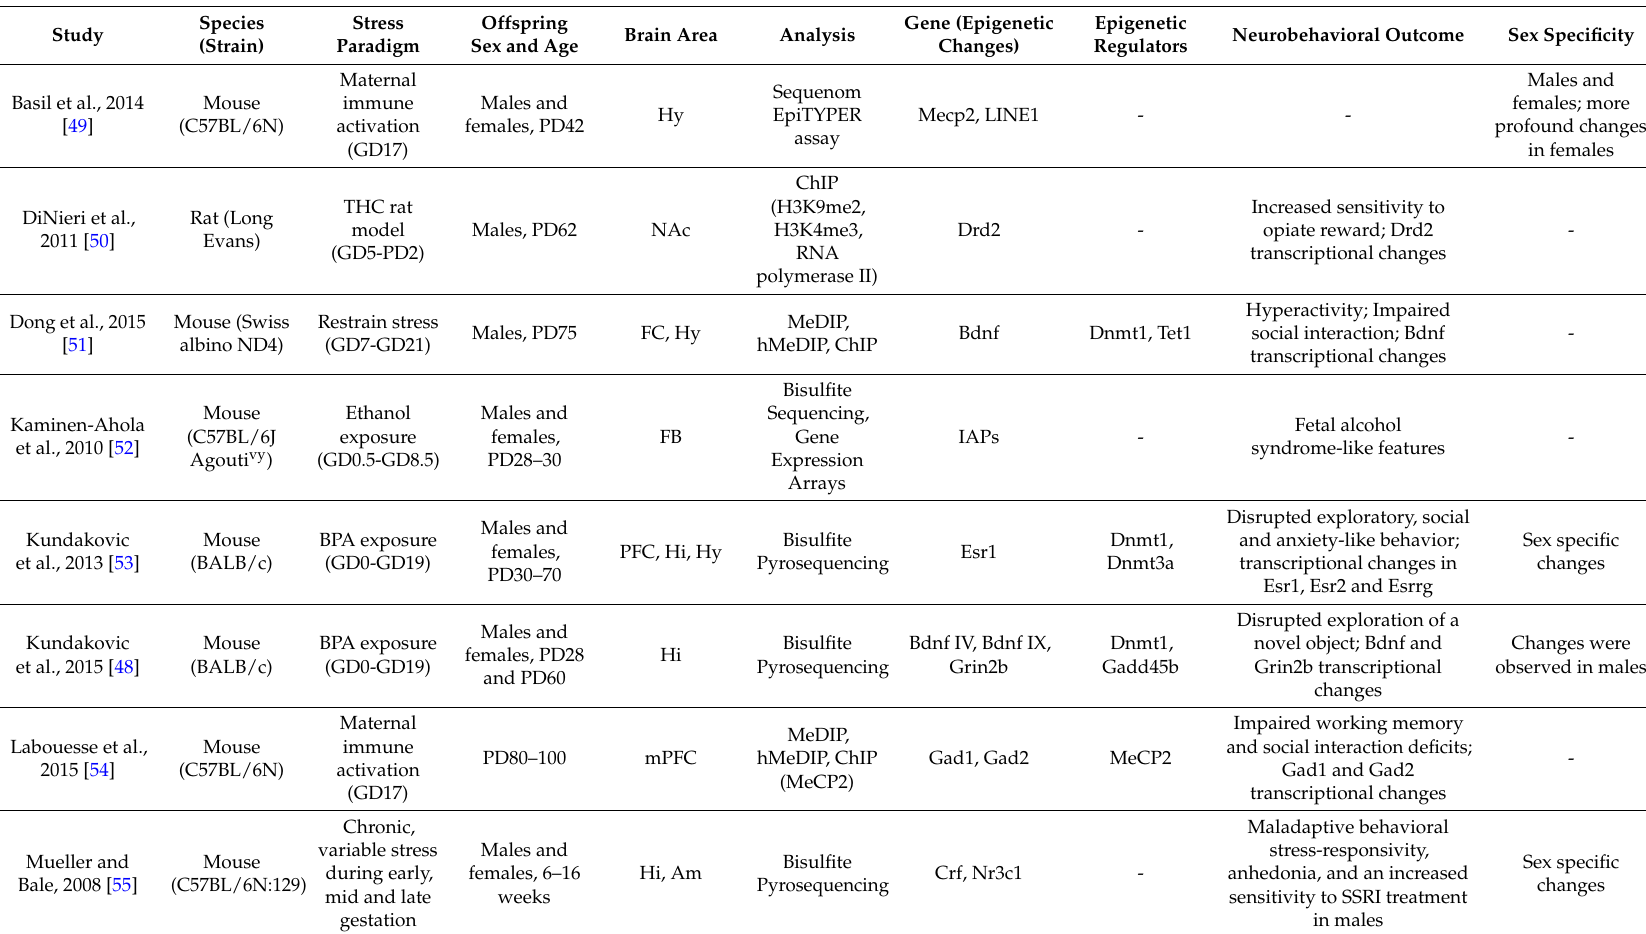
Table 1. Animal studies providing an epigenetic link between prenatal environmental exposure and neurobehavioral